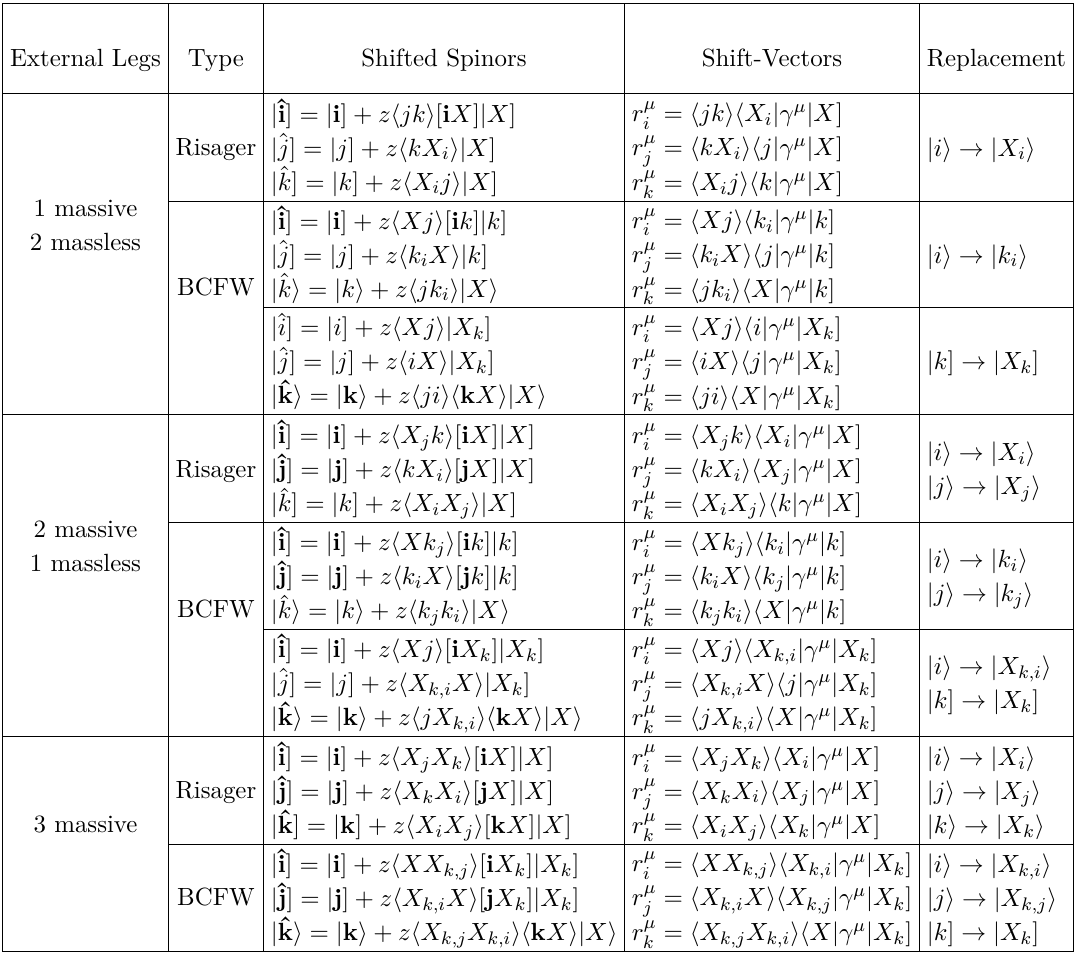
Table 1 . Three-line shifts for all masses, where the little-group indices are